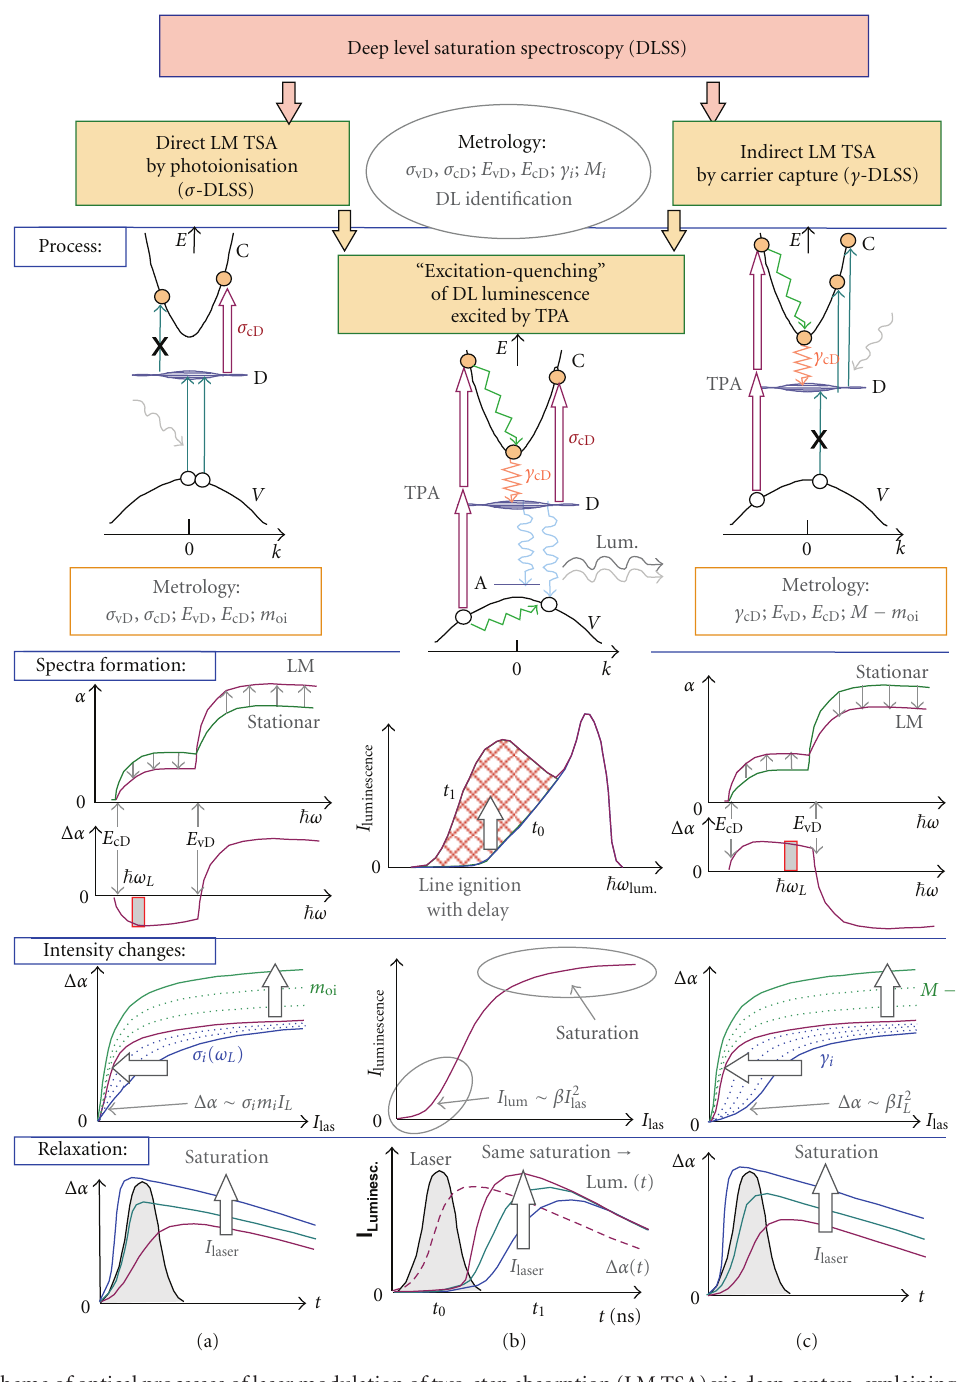
Figure 14: Scheme of optical processes of laser modulation of two-step absorption (LM TSA) via deep centers, explaining a method of “deep level saturation spectroscopy” (DLSS). (a) Direct laser modulation of two-step absorption ( σ -DLSS) from changes of center population by laser photoionization ( σ M ). (b) Competition of σ - and γ -DLSS. E ff ect of laser ”excitation-quenching” of impurity luminescence. (c) Indirect laser modulation of TSA ( γ -DLSS) by capture ( γ M ) of two-photon generated carriers.